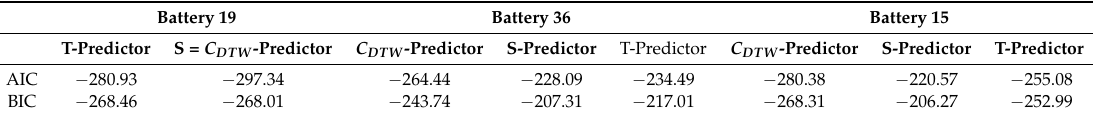
Table 5. Fitted models AIC and BIC values with Dynamic Time Warping (DTW)